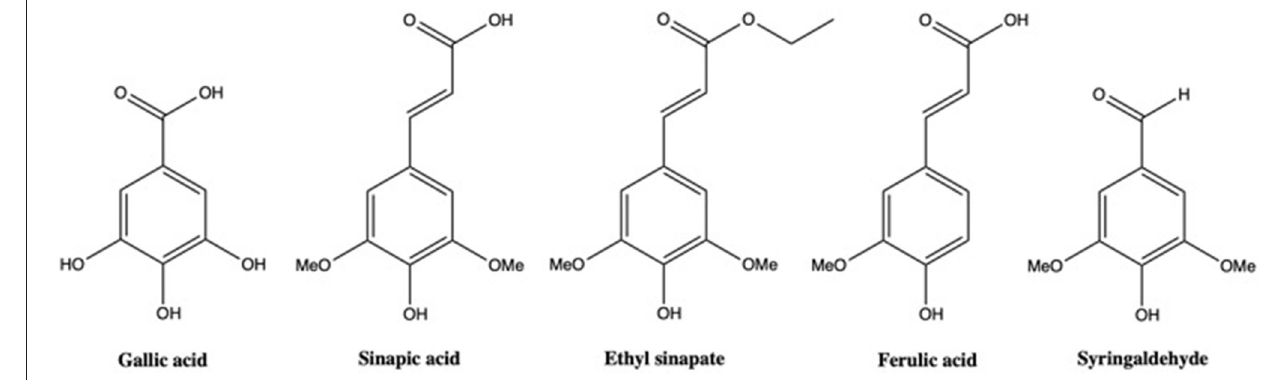
FIGURE 1 | Structure of the five phenolic compounds used for calibration.